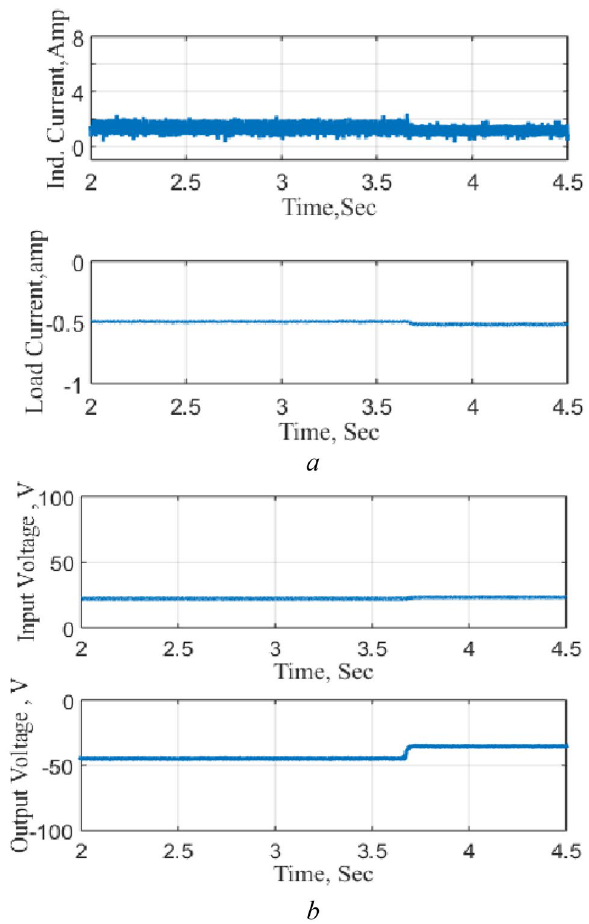
Figure 15. Response to a step decrease, NB. ( a ) Inductor and output currents, ( b ) input and output